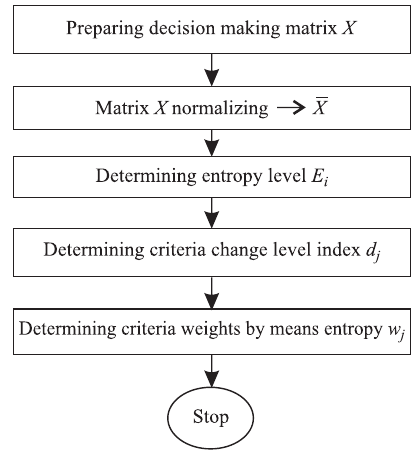
Fig. 5. The block diagram of Entropy method (Zavadskas 1987)